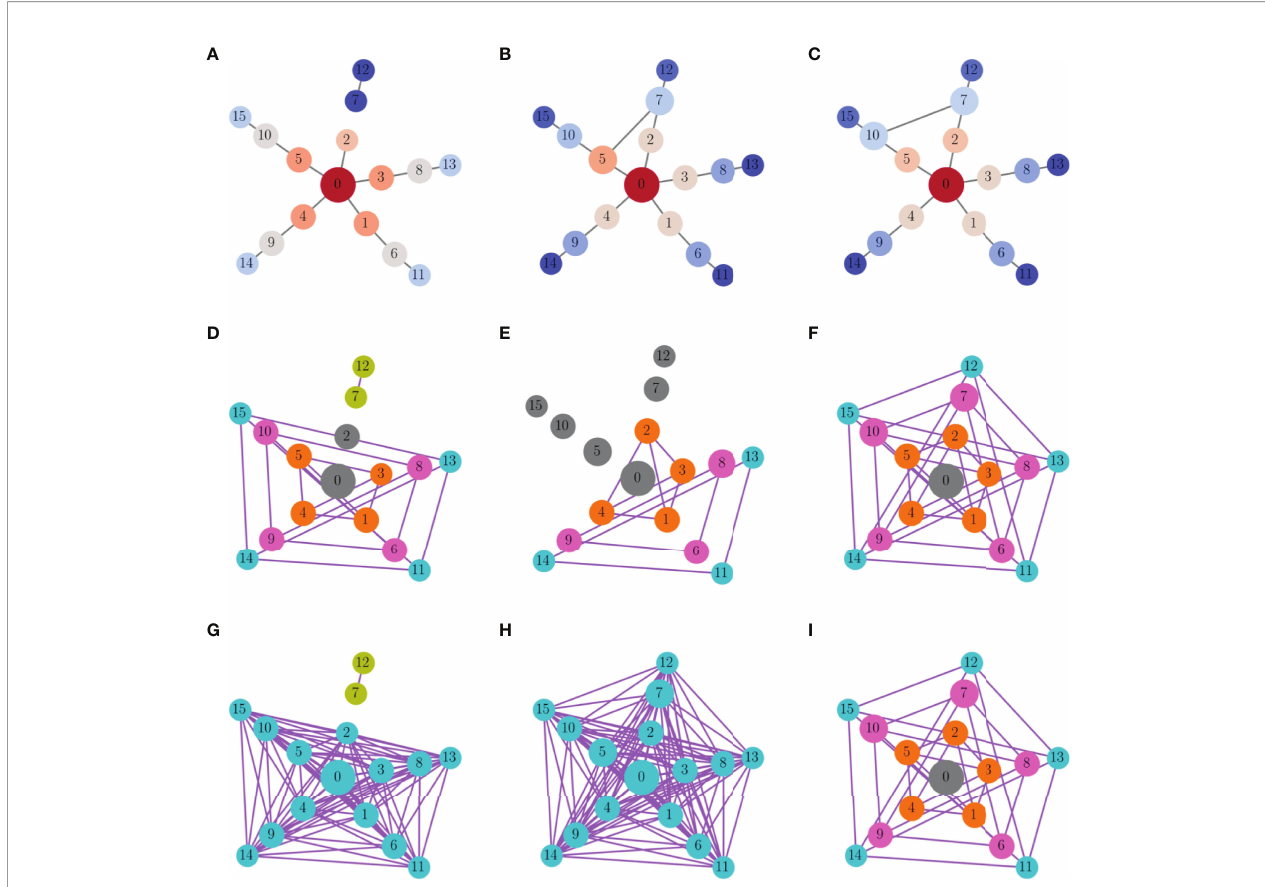
FIGURE 8 | The effects of removing or adding an edge to the multi-arm network. The functional networks in the second and third row correspond to the structural networks on the top row. (A) The edge between nodes 2 and 7 was removed. Nodes are colored according to closeness centrality, and the edge removal changes centrality of nodes 2, 7, and 12. (B) An edge was added between nodes 5 and 7, changing closeness centrality of nodes 5, 7, and 10. (C) An edge was added between nodes 7 and 10, which are the same distance from the center node. This changes closeness centrality in nodes 2, 5, 7, and 10. (D – F) Asymptotic states of the functional network starting from initial conditions corresponding to the ring-synchronized state of Figure 7B . (G – I) Asymptotic states of the functional network starting from initial conditions that produced the ring-synchronized state of Figure 7B .